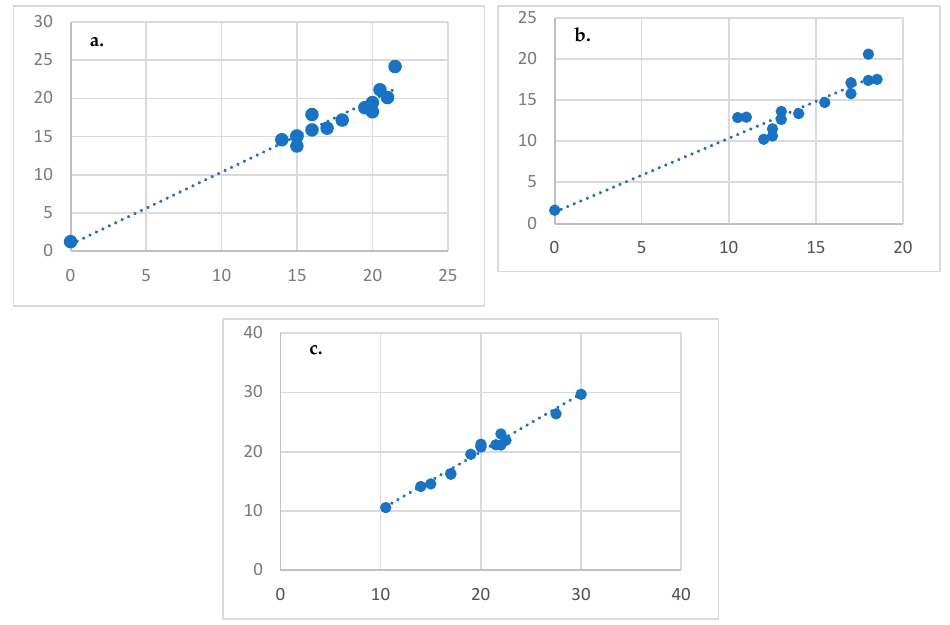
Figure 1. Scatter plot of observed (on x -axis) and predicted (on y -axis) minimum inhibitory concen- trations (MIC) (mg/L) for the antimicrobial activities on: ( a ) S. aureus ; ( b ) E. coli , and ( c ) C. albicans.